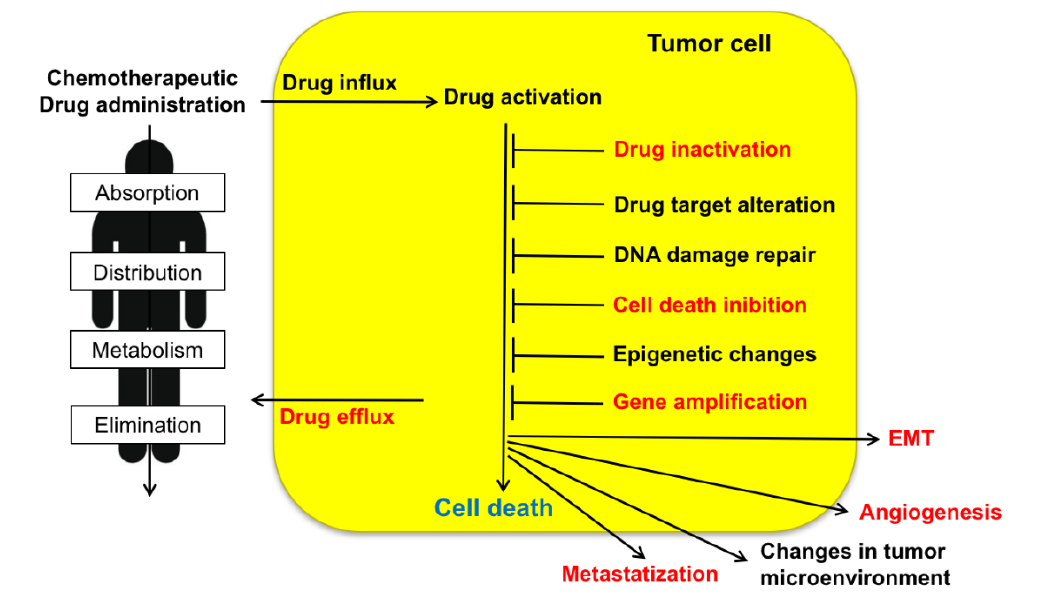
Figure 1. Upon administration of chemotherapeutic drugs, intrinsic or extrinsic factors determine multidrug resistance (MDR). These include absorption, distribution, metabolism, and elimination (ADME), drug influx, drug efflux, drug activation and inactivation, drug target alteration, DNA damage repair, cell death (in particular apoptosis) inhibition, epigenetic effects, epithelial-to-mesenchymal transition (EMT), changes in tumor environment, angiogenesis, metastasis. Sorcin participates in several of such MDR mechanisms (indicated in red, see text). Table 1. Sorcin: Roles in cells, tumors, and multidrug resistance (MDR). Events: